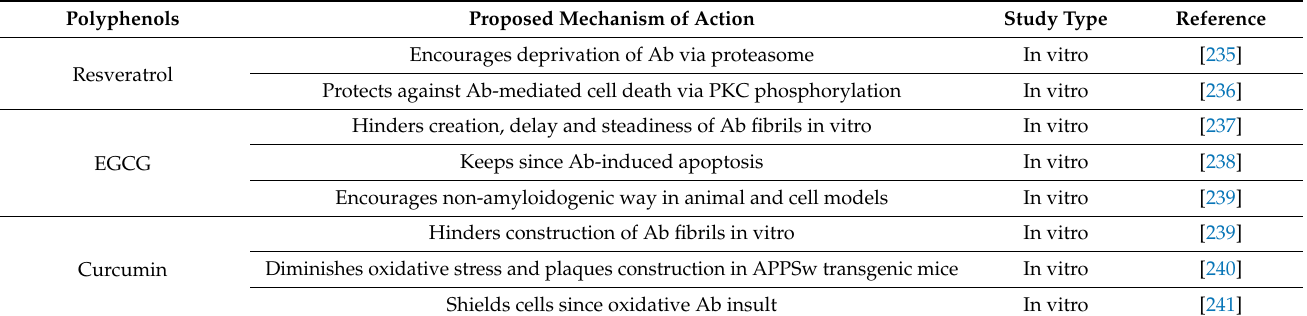
Table 6. Some proposed mechanisms for the beneficial effects of polyphenols in Alzheimer’s disease. Polyphenols Proposed Mechanism of